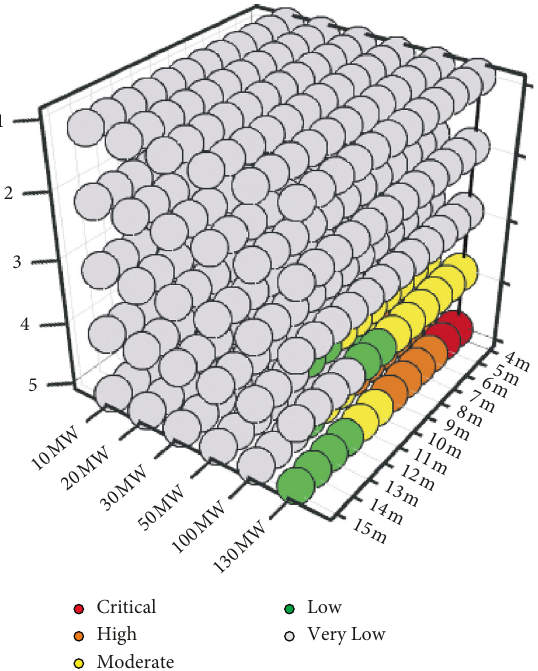
Figure 9: Risk grade model for steel